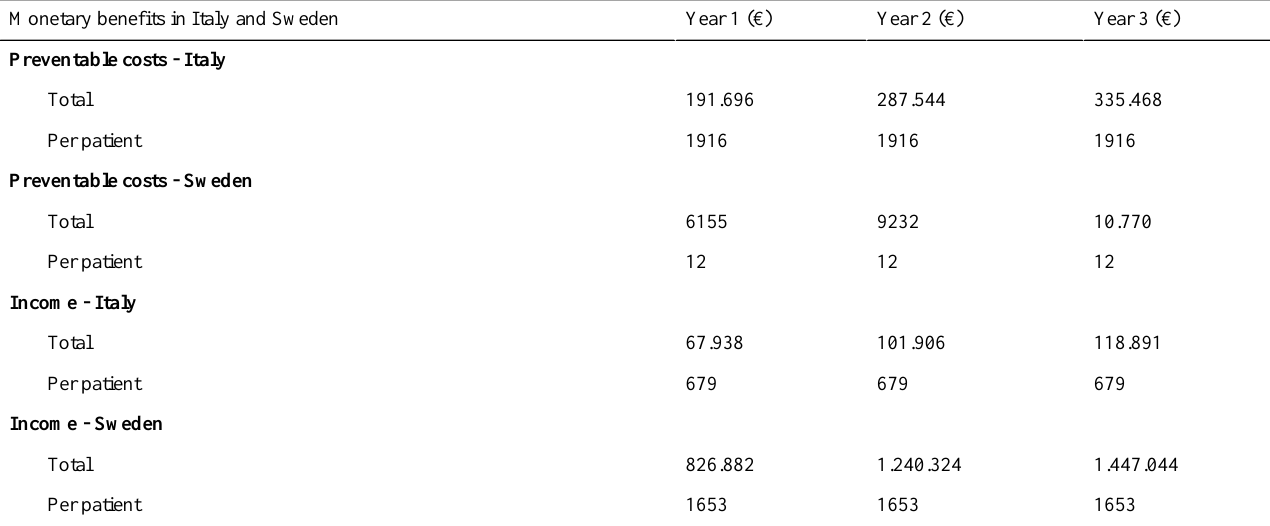
Table 2. Monetary benefits, in euros (a currency exchange rate of EUR €1=US $1.18 is